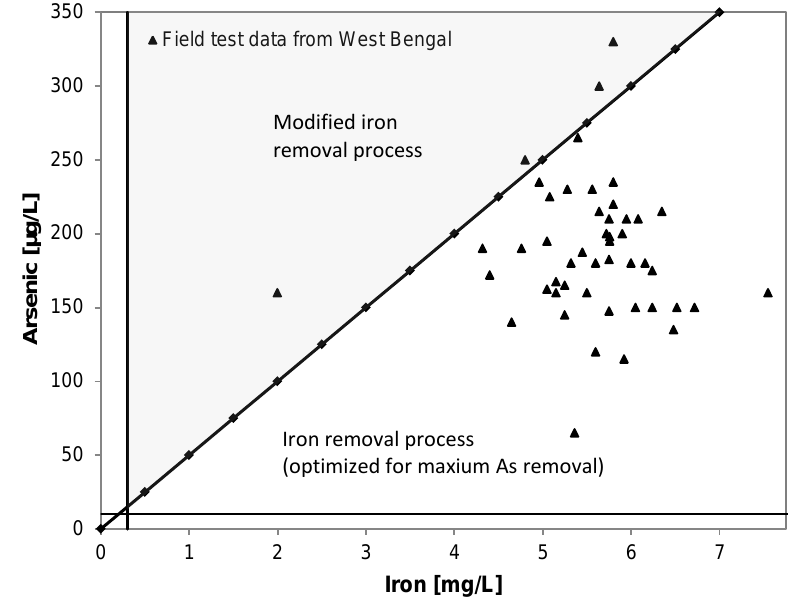
Figure 4. Selection guide for arsenic removal strategy in dependence on initial arsenic and iron concentration in water and Fe/As ratios found during the here conducted field test (after [29]).